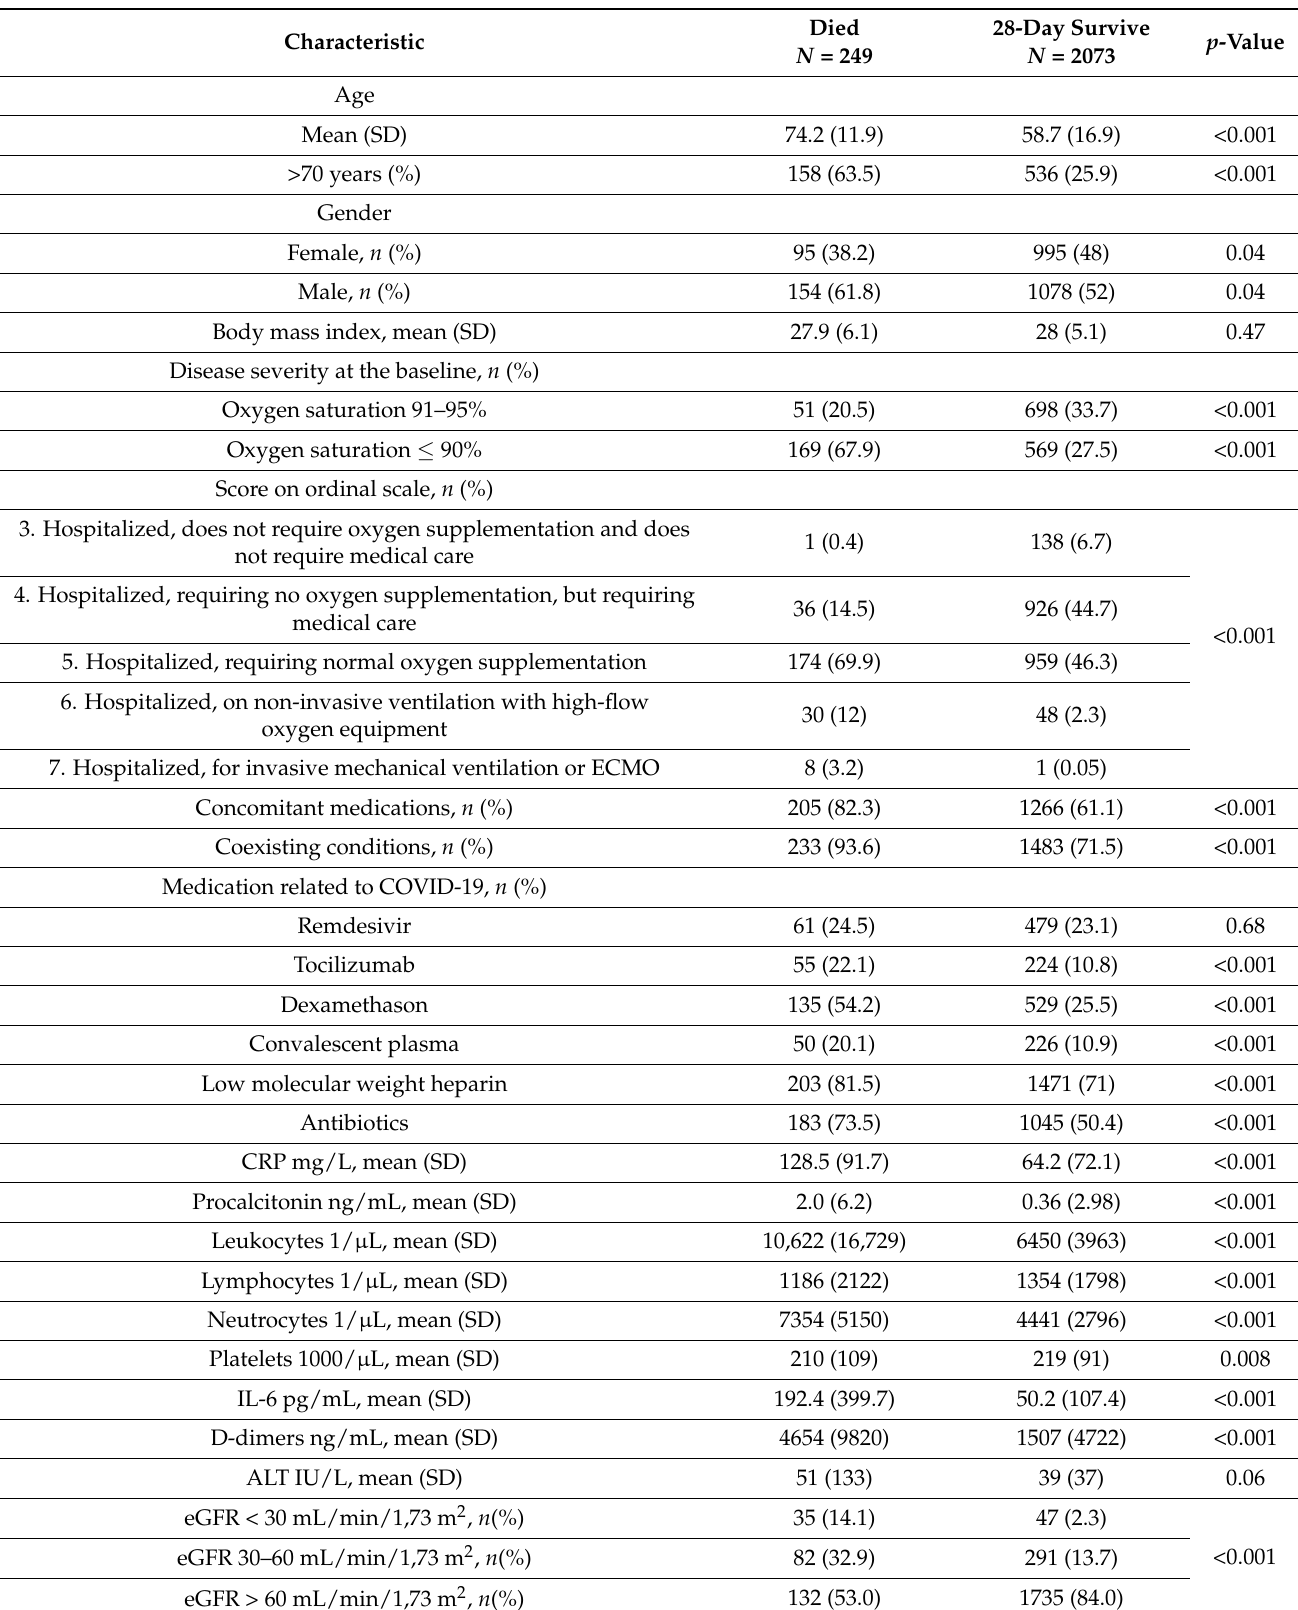
Table 5. Comparison of patients who died or survived regardless of kidney